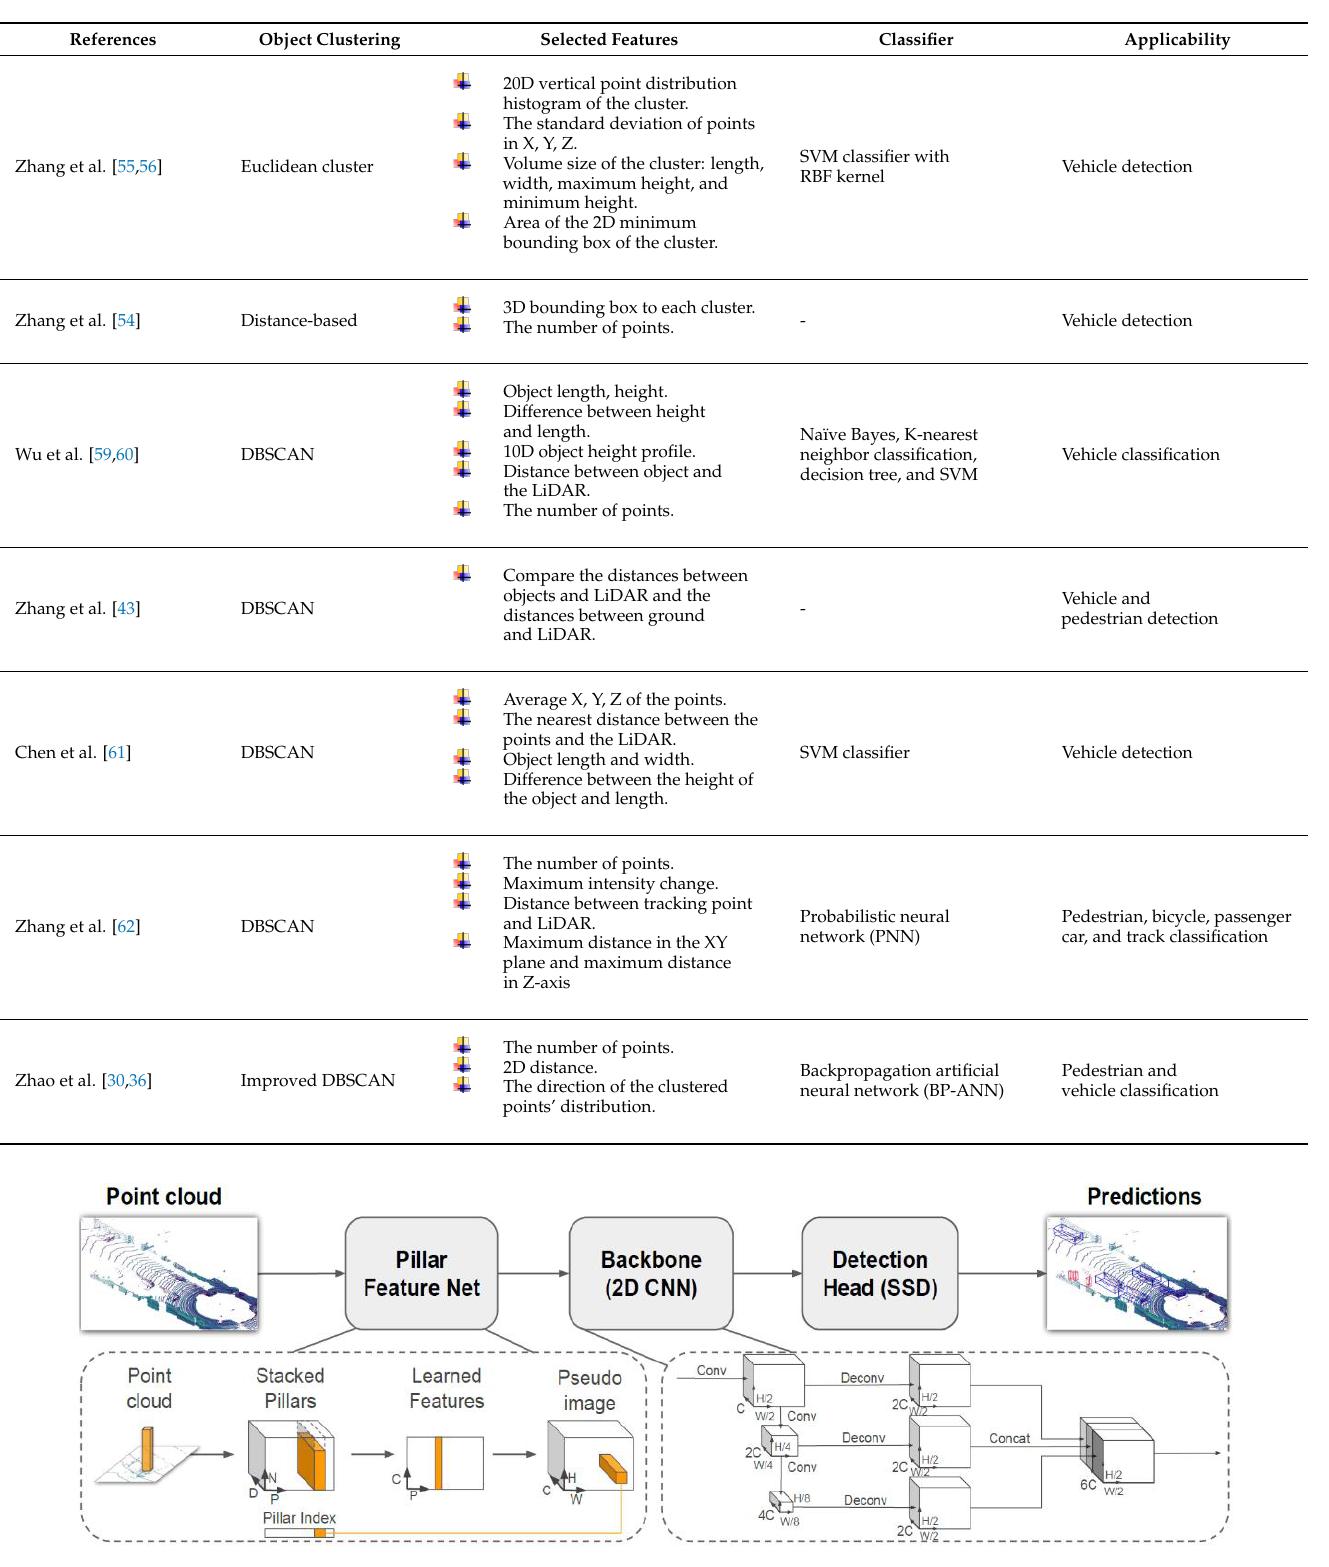
Figure 5. PointPillars 3D object detection model architecture [79]. Table 4. Comparison of object detection methods for roadside LiDAR based on deep learning.